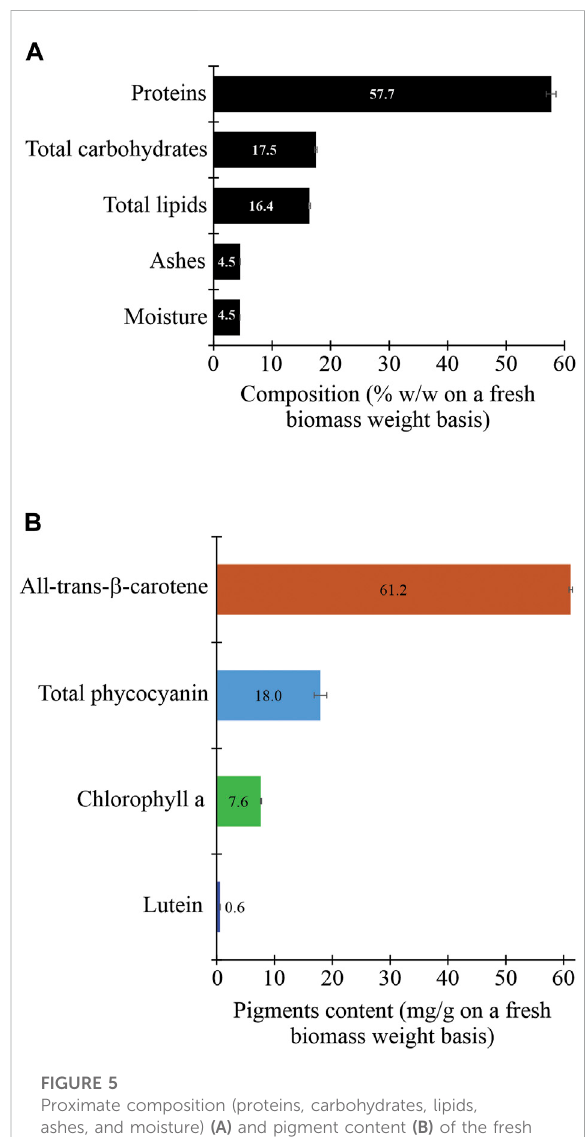
FIGURE 5 Proximate composition (proteins, carbohydrates, lipids, ashes, and moisture) (A) and pigment content (B) of the fresh biomass of the cyanobacterium Synechococcus sp. UCP002 isolated from the Peruvian Amazon Basin region.